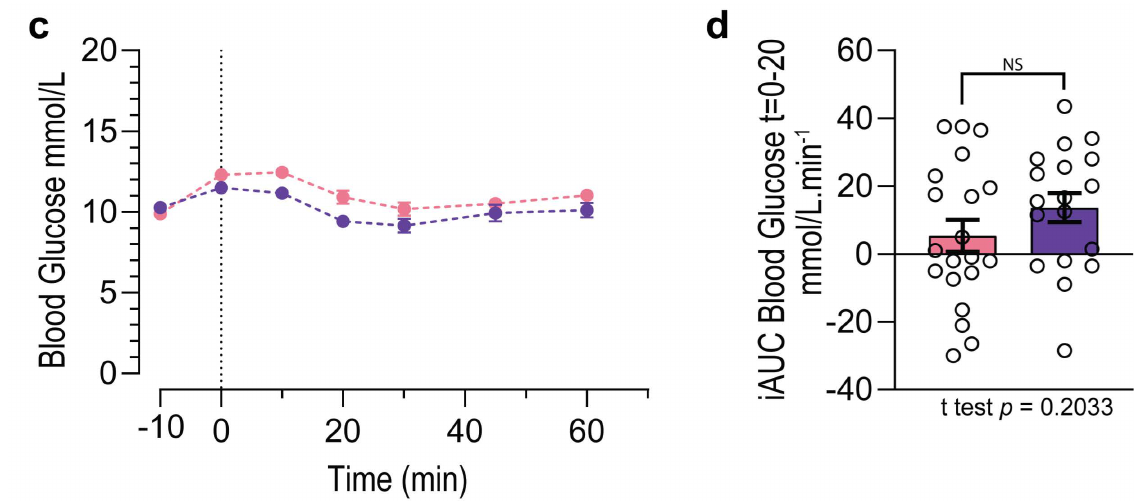
Figure 6. Glucose and insulin tolerance in aged Gpr37l1 − / − and Gpr37l1 +/+ mice. All mice in the cohort 2 group were subjected to a glucose tolerance test (GTT) and an insulin tolerance test (ITT) at 51–52 weeks of age. ( a ) During the GTT, an intraperitoneal glucose bolus (2 g glucose per kg of lean mass) was administered to Gpr37l1 − / − and wildtype ( Gpr37l1 +/+ ) mice, and blood glucose was recorded immediately prior to glucose administration (t = 0 min) and periodically for 90 min afterwards. ( b ) Response was quantified using area under the curve (AUC) analysis after subtraction of basal blood glucose level for each mouse. ( c ) During the ITT procedure, blood glucose was measured twice prior to intraperitoneal insulin administration (1 U per kg of lean mass) at t = 0 min. ( d ) Drop in blood glucose following insulin administration was quantified using an inverse AUC (iAUC) analysis by subtracting the t = 0 glucose value from all timepoints, then calculating AUC between 0 and 20 min. Solid circles and histograms indicate mean; error bars indicate SEM. Open circles represent individual subject values. Data (( b , d ) only) analysed by two-tailed t test. Significance was defined as p < 0.05; NS denotes non significance. ITT: n = 18 for Gpr37l1 − / − , n = 20 for Gpr37l1 +/+ ;